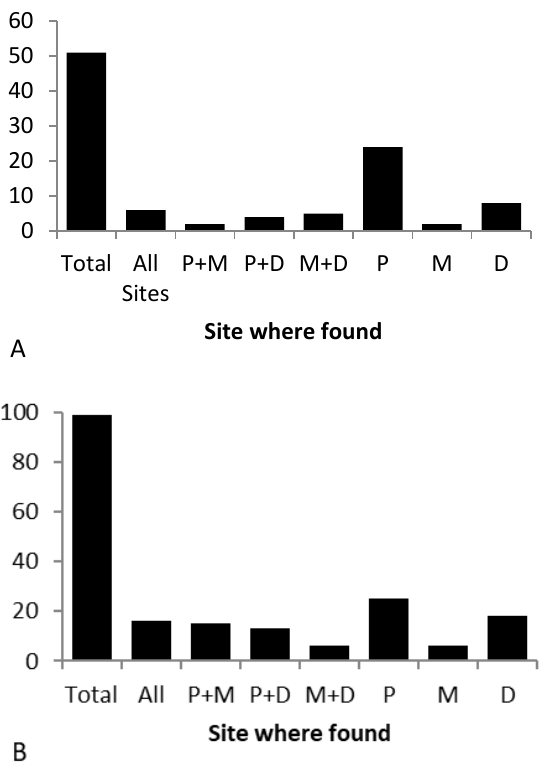
F IGURE 2: The number of (A) plant species, and (B) pollinator species found in total and in common across the three sites. P=Pristine; M=Late Successional; D=Early